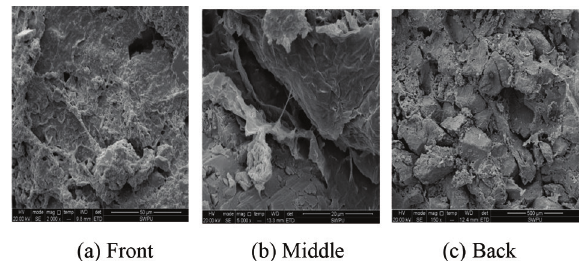
Figure 5: Microscopic structure of core